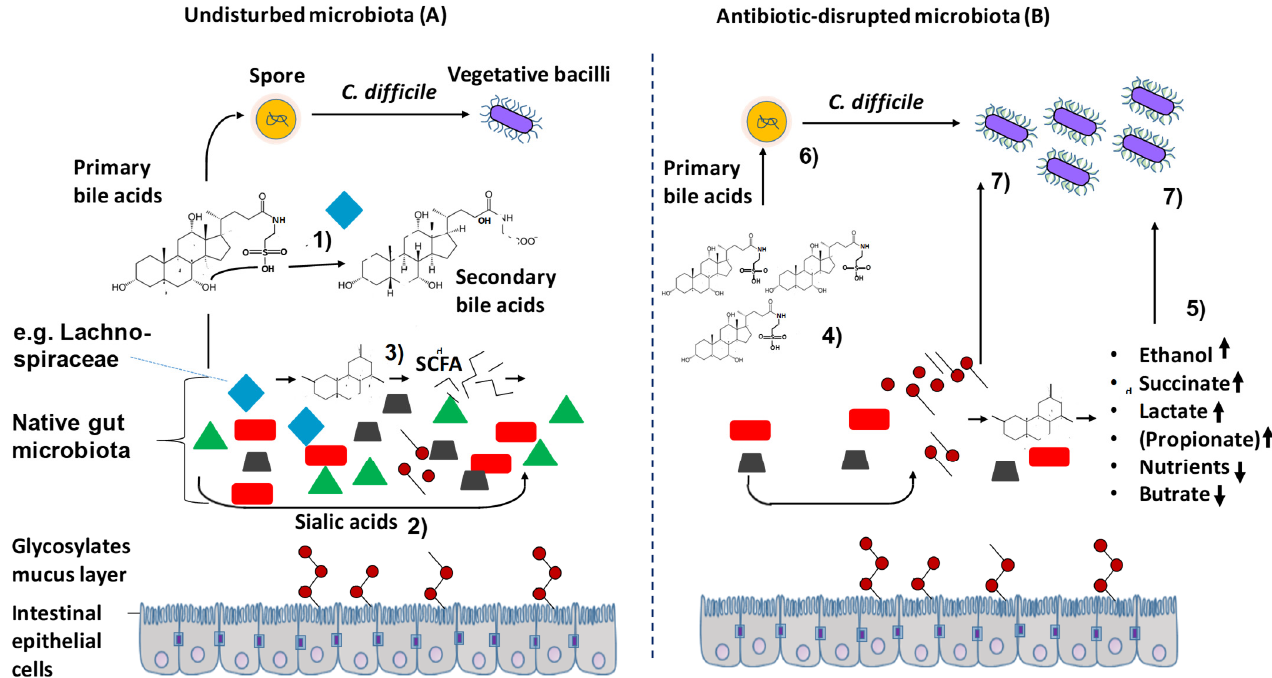
Figure 8. The role of the indigenous gut microbiota on CDI. Microbiota-mediated defense with native microbiota ( A ), omission of defense mechanism after antibiotic caused disruption of microbiota ( B ), modified from [17] and supplemented with our own correlation data.